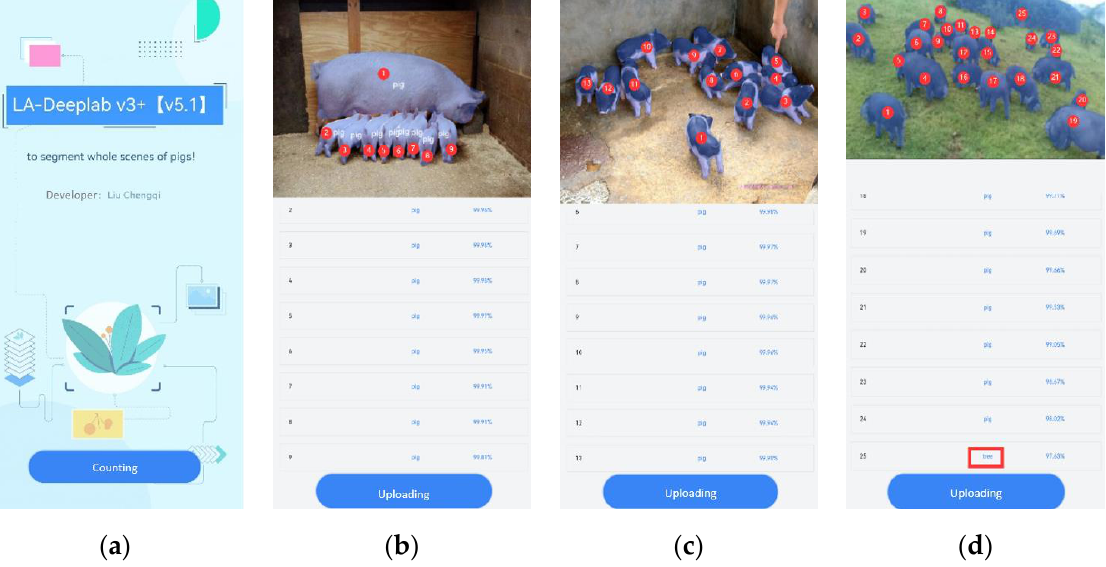
Figure 13. Counting application of pigs in complex environments based on the H5 program. ( a) The home page; ( b ) The lightweight image (1 – 10 pigs); ( c ) The middle-weight images (10 – 20 pigs); ( d ) The heavyweight images (more than 20 pigs)